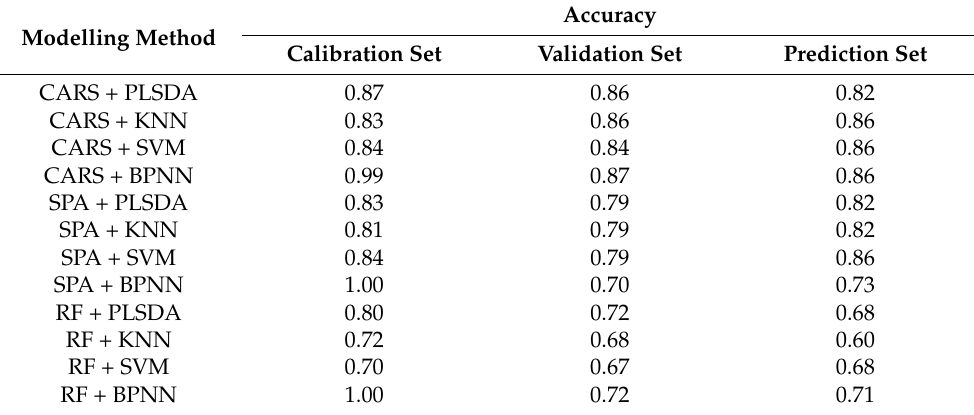
Table 4. Accuracy performance based on a combination of classification models and variable selection